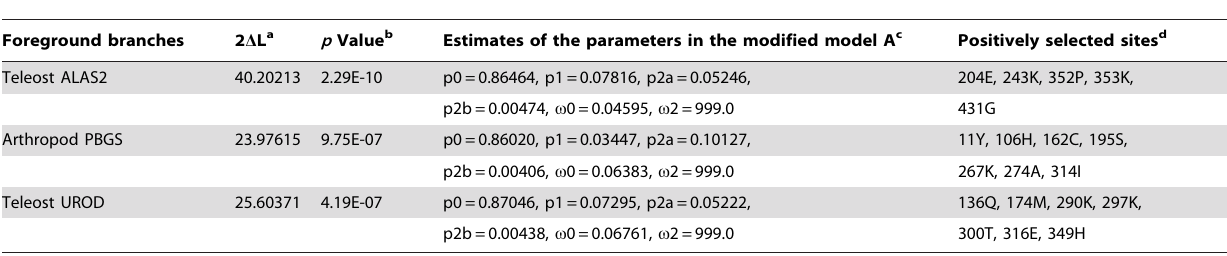
Table 3. Positive selection in the different lineages of genes of heme biosynthesis pathway.